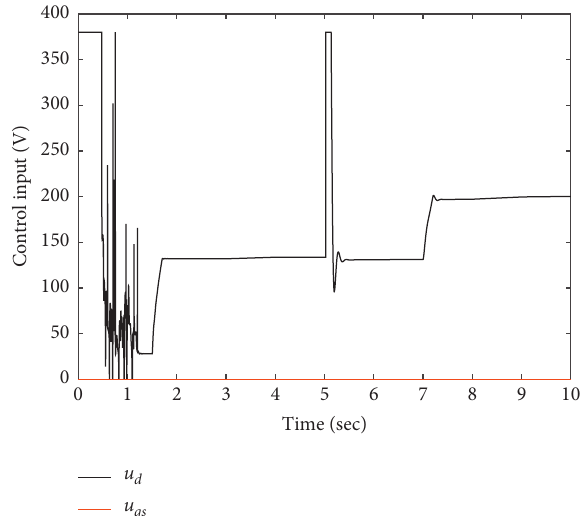
Figure 13: Time profiles of control inputs (noisy